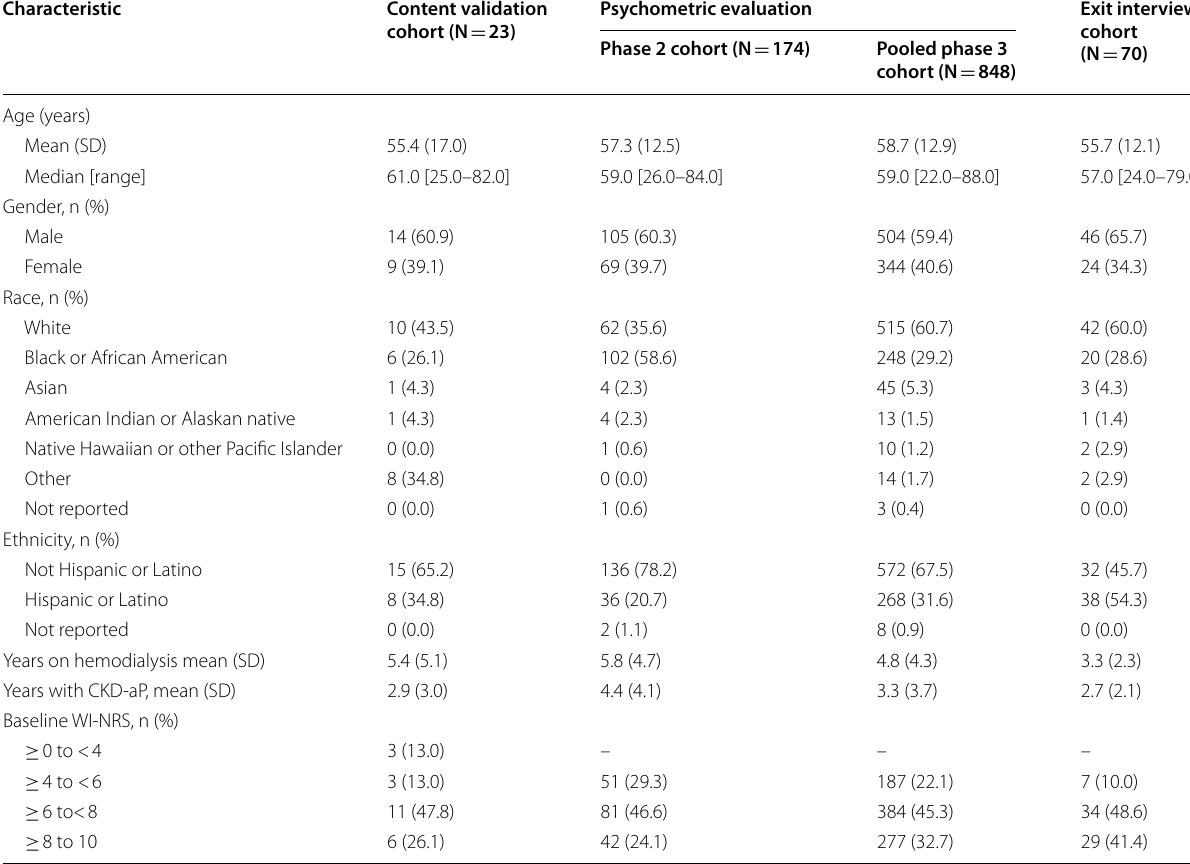
Table 2 Patient